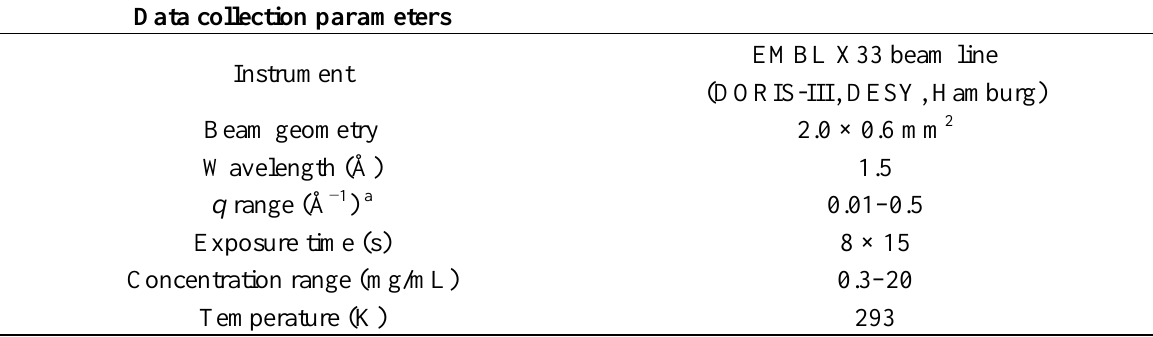
Table 2. SAXS Data collection and derived parameters for PaoABC. Abbreviations: M : molecular mass; R : radius of gyration; D : maximal particle dimension; V r g max volume; V : Particle excluded volume. a Momentum transfer | q | = 4πsin(θ)/λ. b Values ex reported for the data merged data set (0.3 & 10